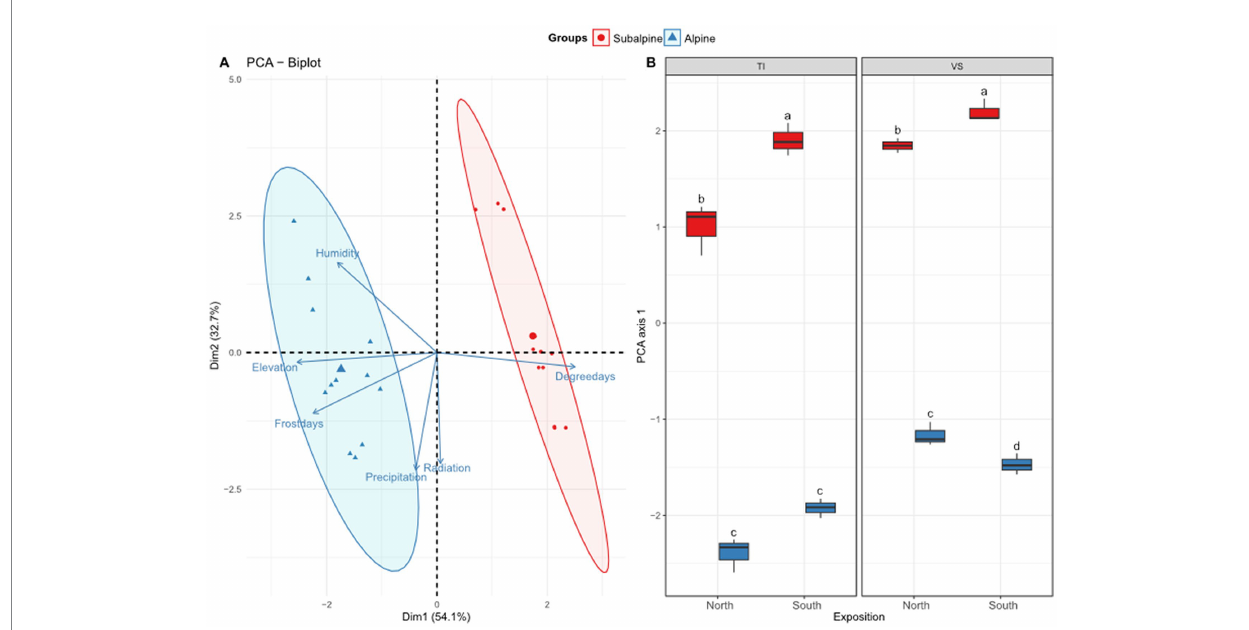
FIGURE 2 Climatic niche. Shown is (A) the principal component analysis (PCA) biplot of six climatic variables retained in the analysis: relative evapotranspiration (humidity), elevation of each site, number of frost (<0 ° C) days during the year (frost days), annual mean precipitation (precipitation), annual mean solar radiation (radiation), average number of degree-days per year (degree days). (B) Boxplots representing average values along the first axis of the PCA separated by exposition (north versus south facing slopes), and regions (Ticino = TI, or Valais = VS ). Letters above boxplots represent significant